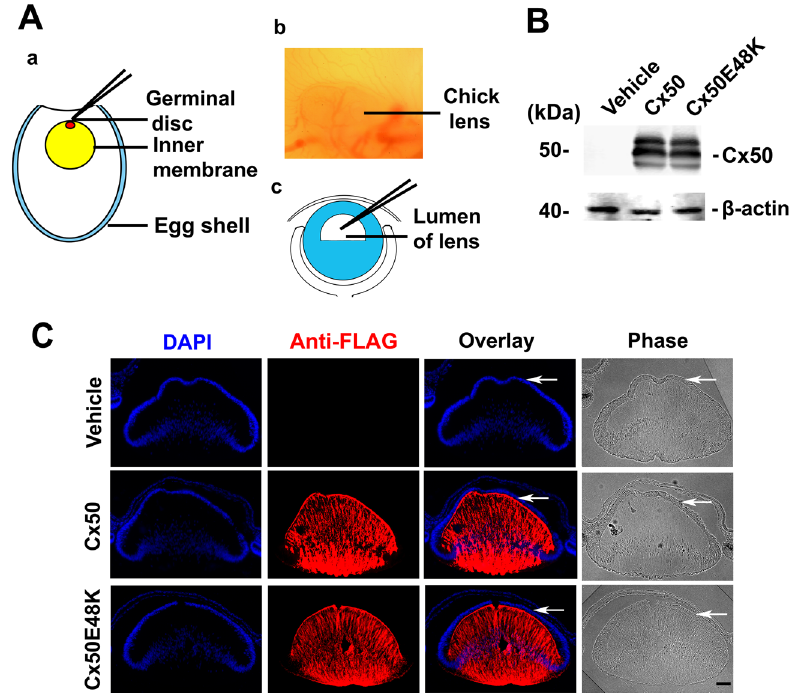
Fig. 1 Expression of exogenous connexins in embryonic chick lens in situ. A At 68 h of embryonic development (around developmental stage 18), eggshells were incised to reveal live embryos (a and b). Approximately 20 nL solution containing high-titer retrovirus expressing recombinant proteins was microinjected into the lens lumens (c). B 48 h after retroviral infection, chick embryonic lenses were collected and crude membrane extracts were prepared. The expression of Cx50 and the Cx50E48K mutation was detected by western blotting using an anti-FLAG tag antibody. C 48 h after infection, chick embryonic lenses were collected and immunostained with anti-FLAG antibody and counter-nuclei stained by DAPI. White arrows show epithelial cells at the anterior region of the lens. Bar, 50 µ